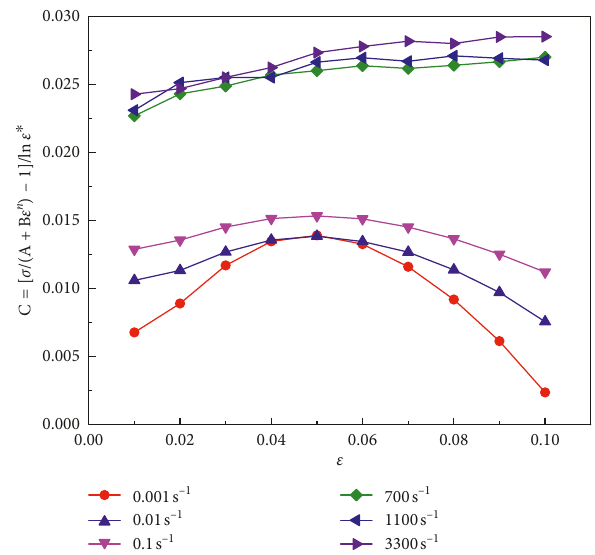
Figure 8: Relationship between C and ε